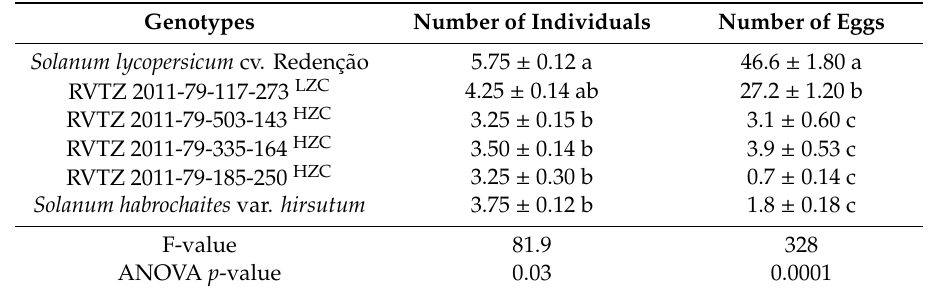
Table 2. Number (± standard error) of live adults and eggs of Tetranychus urticae mites on the abaxial face of leaf discs of tomato genotypes in no-choice oviposition bioassays ( n = 10).